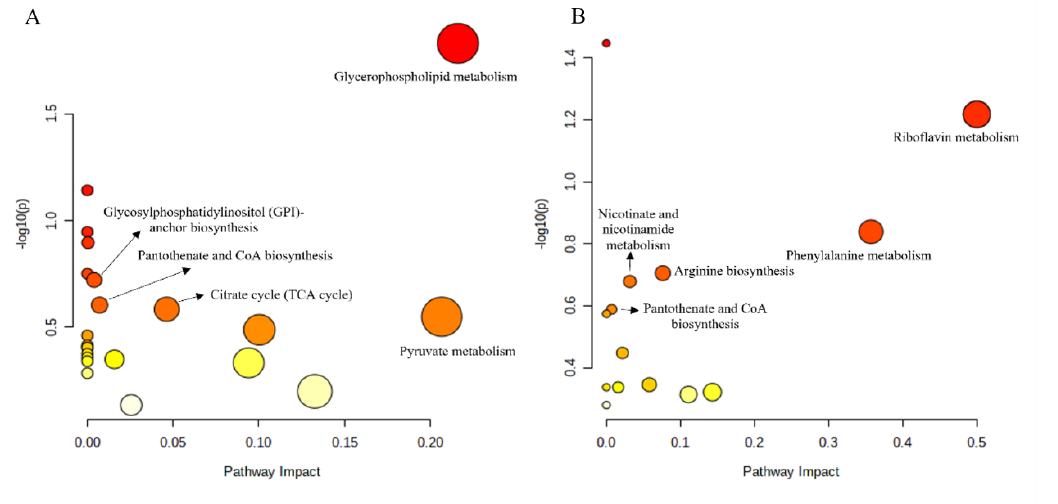
Figure 5. Pathway analysis of the differentially expressed metabolites between CK group and GM group ( A ) or CK group and GI group ( B ). The x - axis (−log 10 ( p -value)) represents the pathway enrichment score and the y -axis represents the pathway impact score. Pathway impact score is proportional to the bubble size. The significance level of the pathways is denoted by the bubble color, ranging from highest (red) to lowest (white).